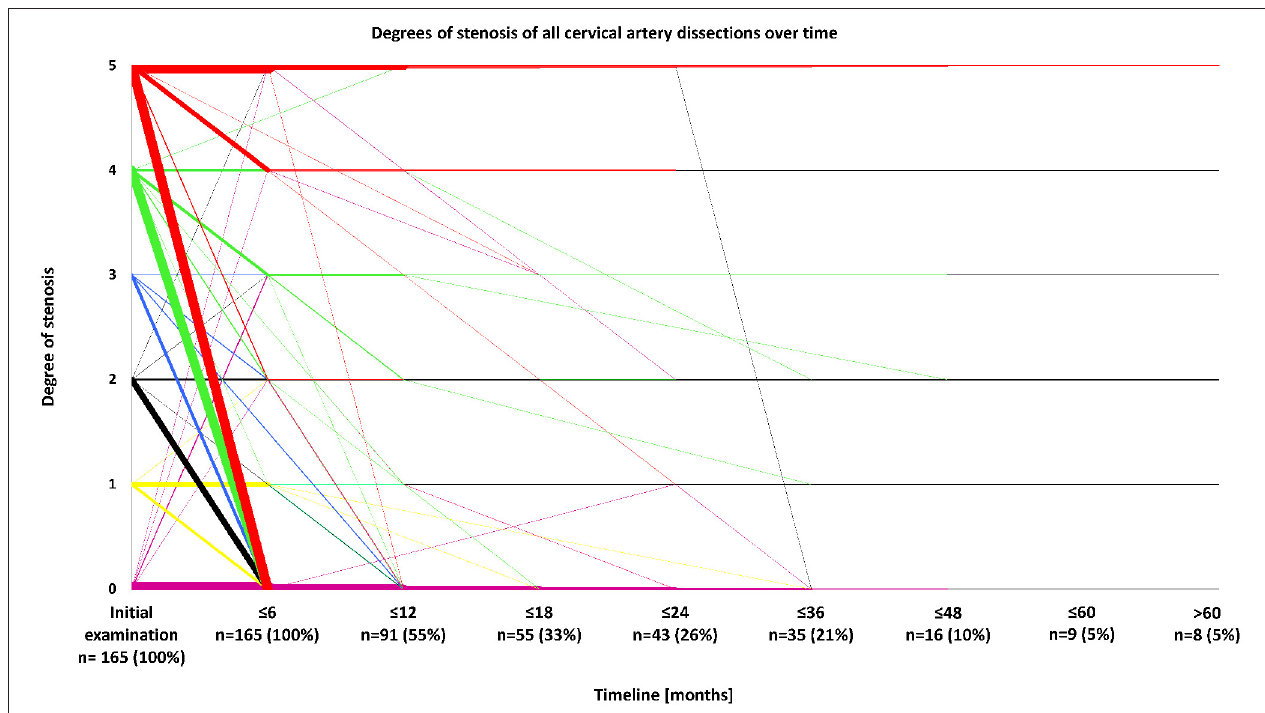
FIGURE 3 | Degrees of stenosis of all cervical artery dissections over time. Degrees of stenosis were classified by neurovascular ultrasound according to the following scheme: 0: No visible stenosis, 1: Stenosis without hemodynamic relevance, 2: ≥ 50% difference in flow and/or acceleration of flow comparing healthy and affected sides, 3: 60–80% stenosis, 4: > 80% stenosis, and 5: Arterial occlusion. N-numbers refer to patients being followed up for a certain period of time.